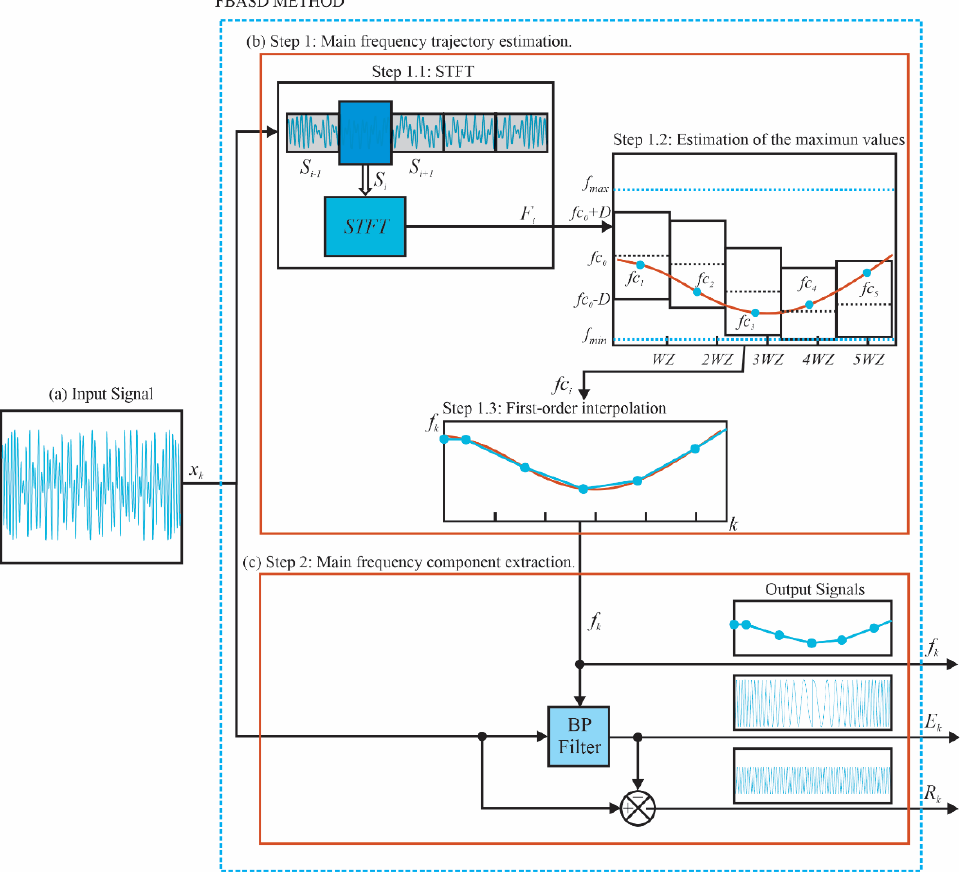
Figure 1. FBASD methodology. ( a ) Input signal, ( b ) Step 1: Main frequency trajectory estimation, ( c ) Step 2: Main frequency component extraction.